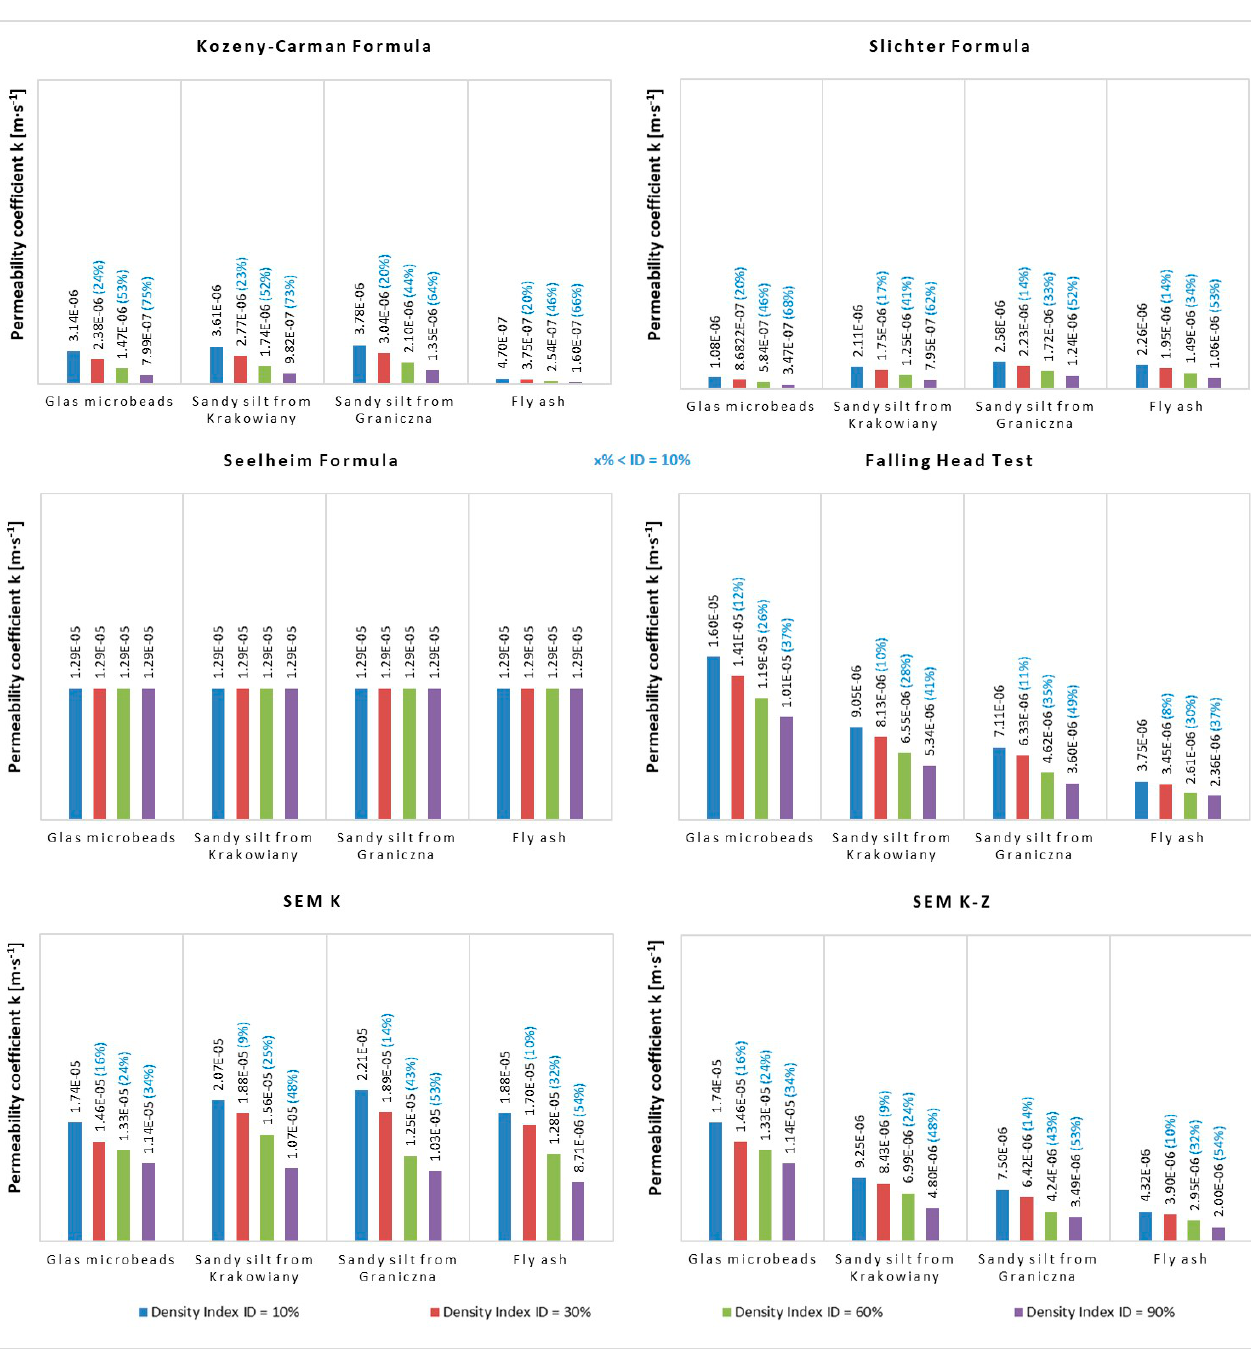
Figure 8. The values of permeability coefficient k obtained with the same method for different soils in relation to the density index I D